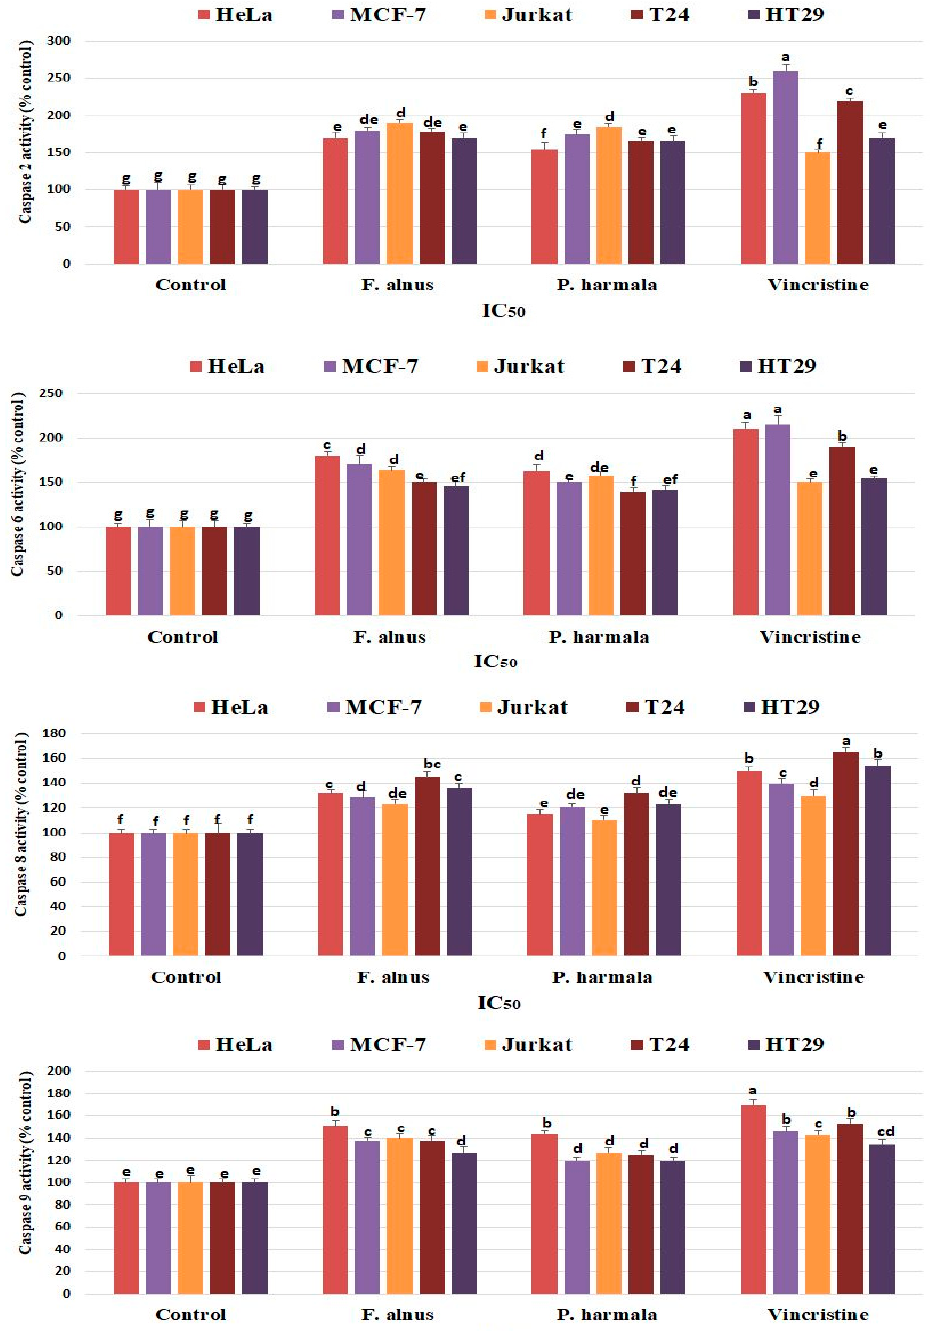
Figure 5. Enzyme activity of caspase 2, 6, 8 and 9 following treatment of different cancer cells with F. alnus and P. harmala leaf extracts (IC 50 ). The results showed that increased caspase activity occurred after F. alnus and P. harmala treatment in all cancer cell lines compared to the control cells. The activity was expressed as a percentage (%) of control. The values are means ± SDs of three series of experiments. Different letters among columns indicate significant differences at P ≤ 0.05 .